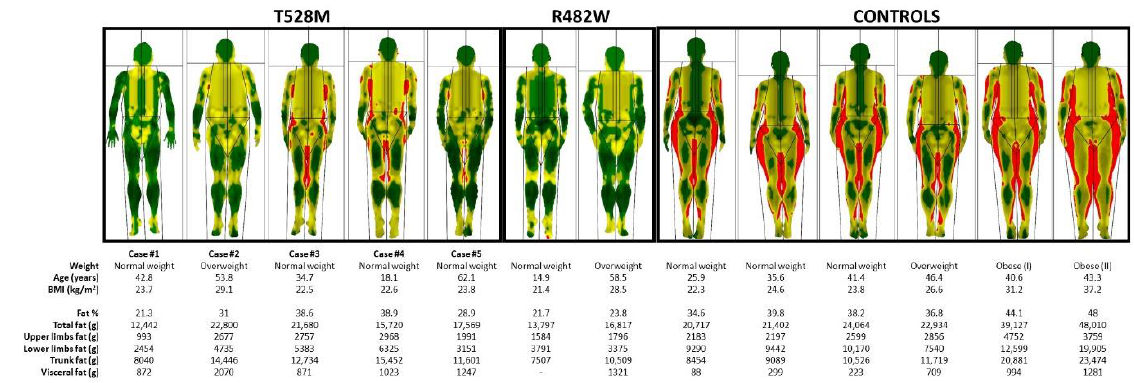
Figure 3. DXA scans of patients with the p.(Thr528Met) and p.(Arg482Trp) variants in the LMNA gene and control subjects. The total body scans were color-mapped, with green representing an area of low level % fat (0–25%), yellow an area of medium level % fat (25–60%) and red an area of high level % fat